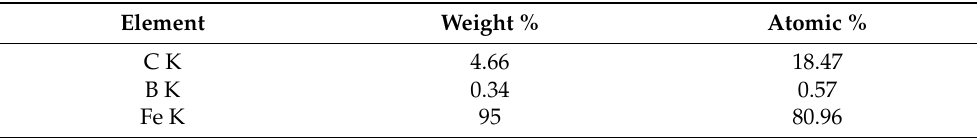
Figure 13. EDX analysis spectrum at point C in specimen welded at normal conditions. Table 10. EDX quantitative analysis data at point C in specimen welded at normal